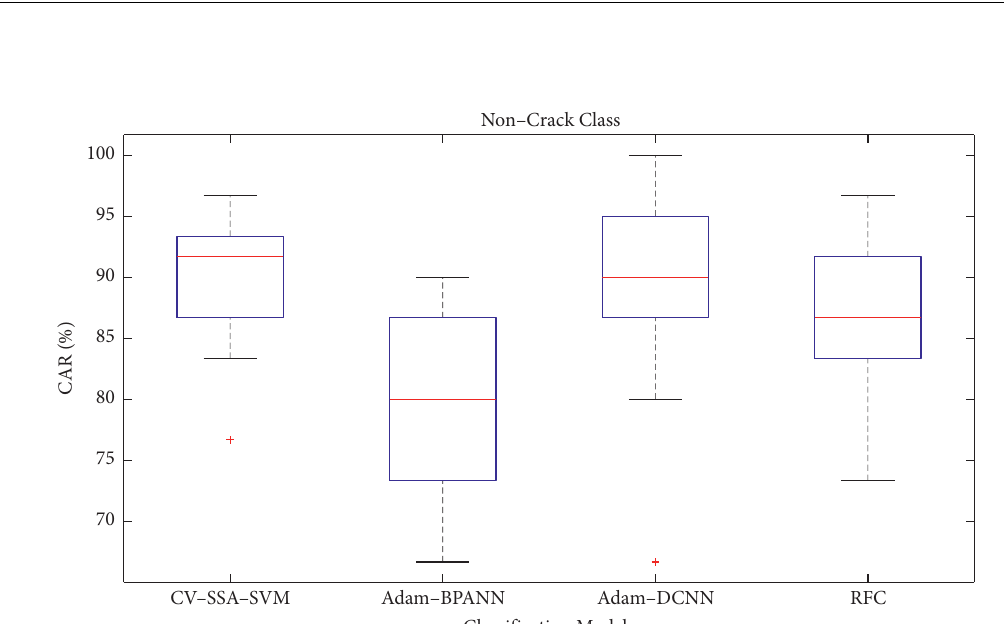
Figure 13: Box plot of classification accuracy for the “noncrack”